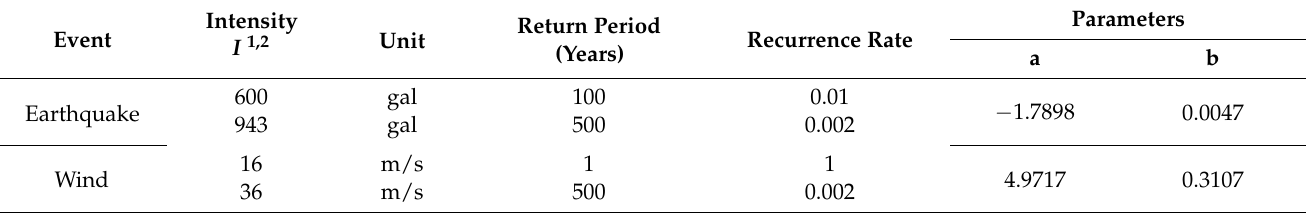
Table 4. Parameters of the probabilistic distribution of earthquake and wind intensity for Aichi Prefecture Japan. Event